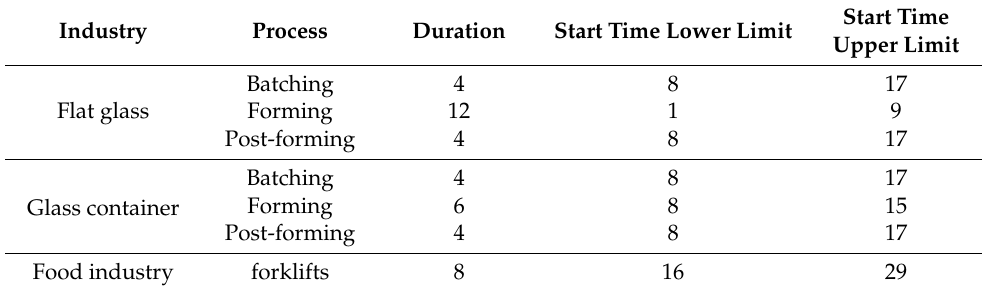
Table 13. The upper and lower limits of start times (in